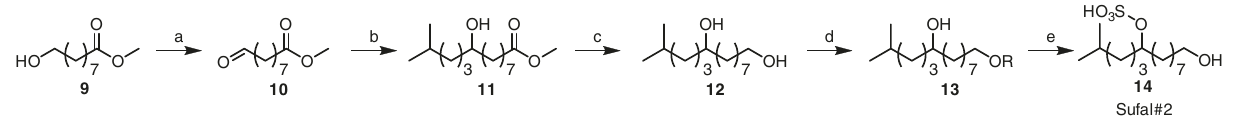
Fig. 7 Overview of synthesis of sufal#2. Reagents and conditions: a Pyridinium chlorochromate (PCC), DCM, 0 °C; b Mg, THF, argon; c LiAlH 4 , THF; d TBDPS-Cl, imidazole, THF; e SO 3 /pyridine complex,